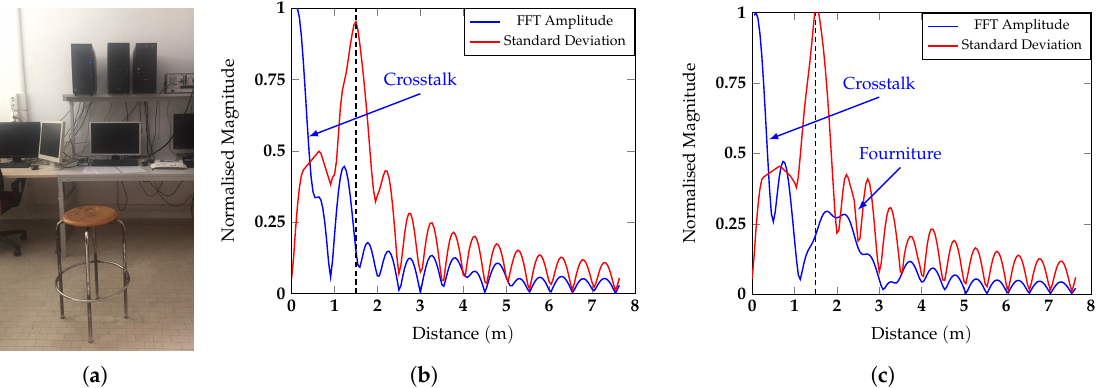
Figure 6. ( a ) Photo of the measurement environment and the effect of the standard deviation on the radar signal ( b ) when the subject had the chest facing the antenna and ( c ) when the subject had the side towards the